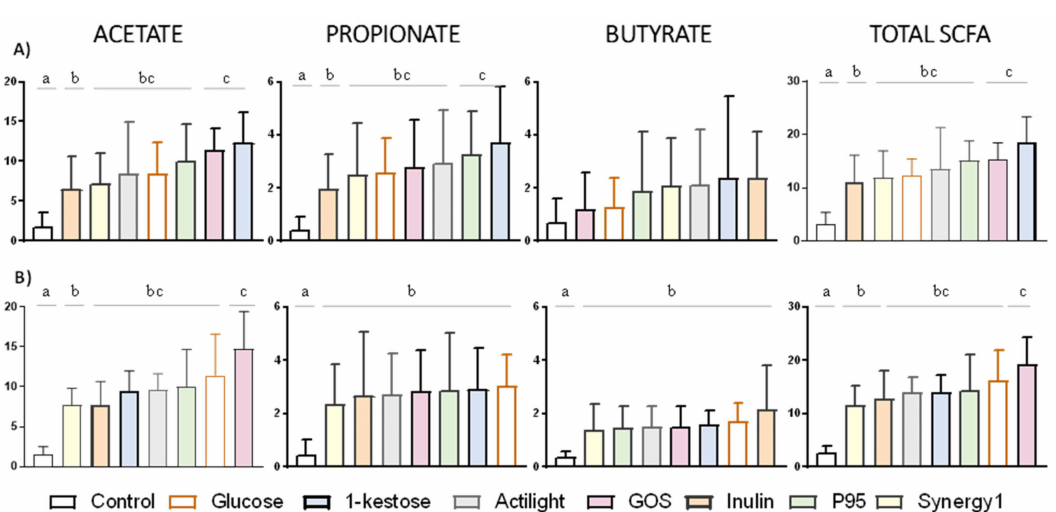
Figure 3. Increments in ascending order, with respect to time 0, in the concentration (mM) of the major short-chain fatty acids (acetic, propionic and butyric) after 24 h of incubation with di ff erent carbon sources in fecal cultures from MOB ( A ) and NW ( B ) groups. Di ff erences are shown for each short-chain fatty acid (SCFA); columns that do not share the same letter are significantly di ff erent ( p <